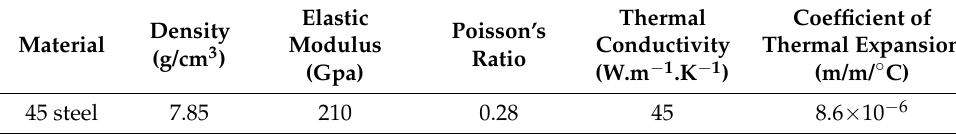
Table 2. Chemical composition of 45 steel.